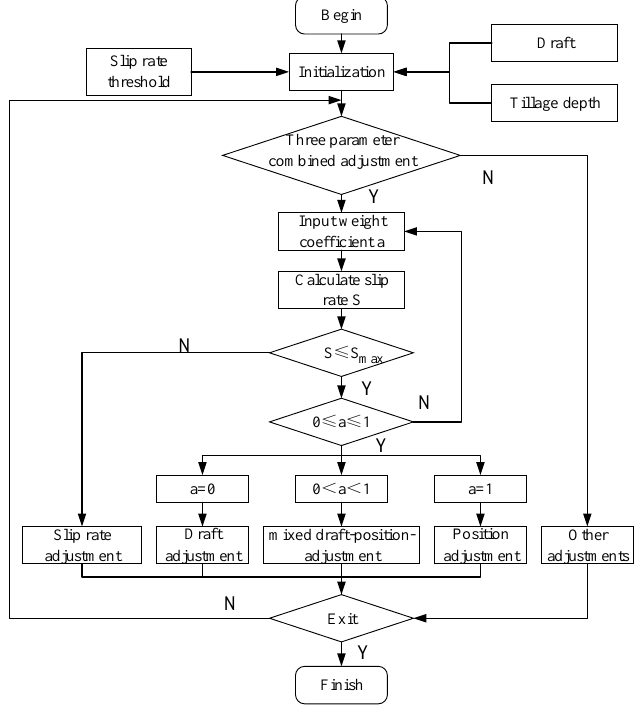
Figure 5. Three − parameter comprehensive adjustment scheme based on the logic